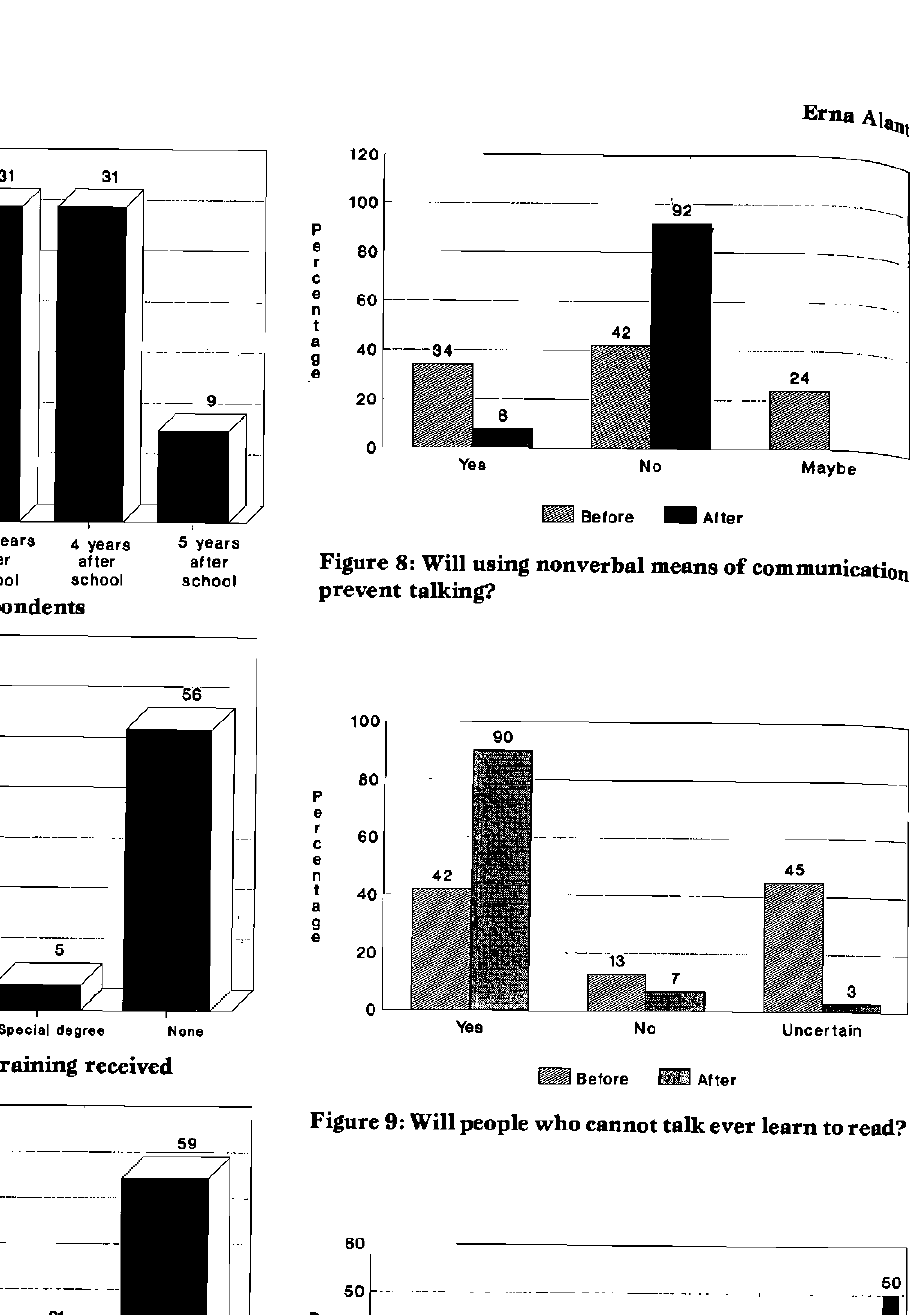
Figure 9: Will people who cannot talk ever learn to read?